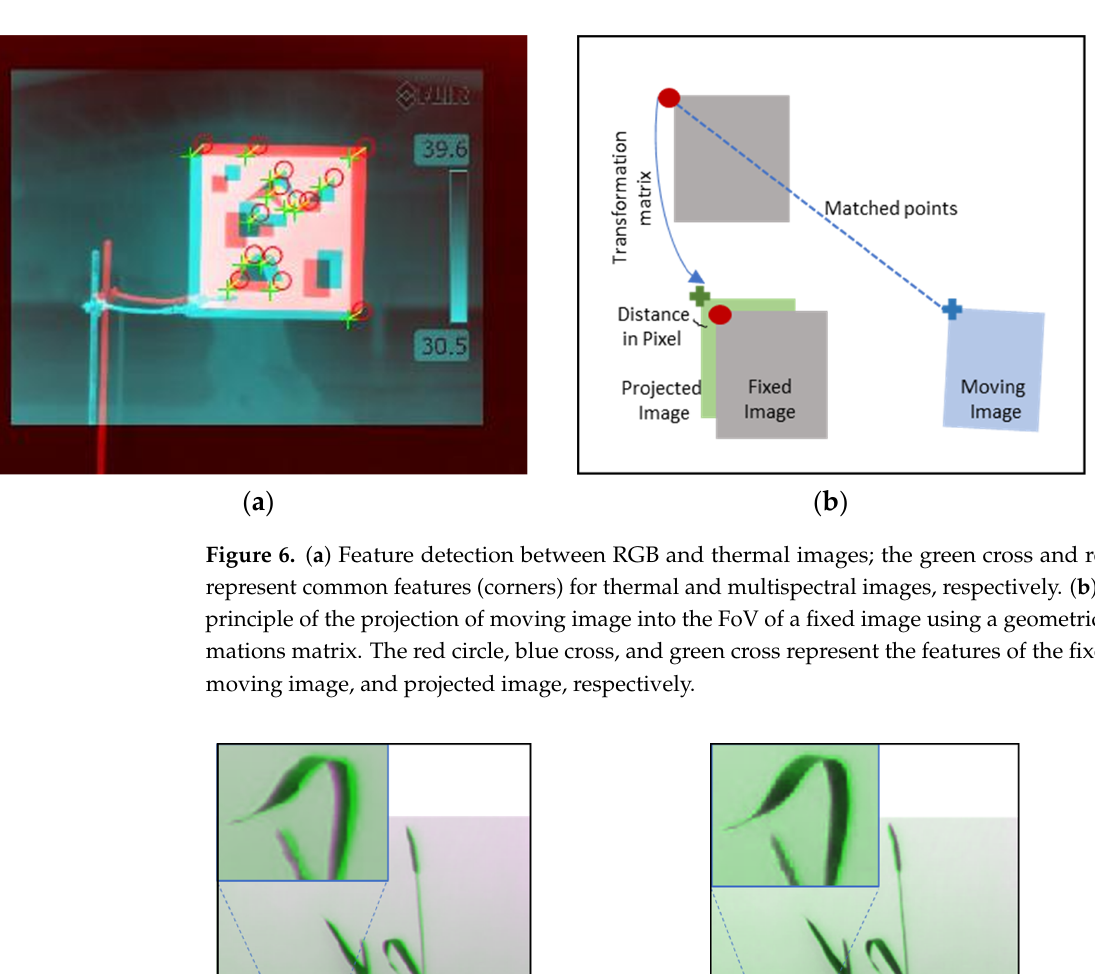
Figure 6. ( a ) Feature detection between RGB and thermal images; the green cross and red circles represent common features (corners) for thermal and multispectral images, respectively. ( b ) Work- ing principle of the projection of moving image into the FoV of a fixed image using a geometric transformations matrix. The red circle, blue cross, and green cross represent the features of the fixed image, moving image, and projected image, respectively.